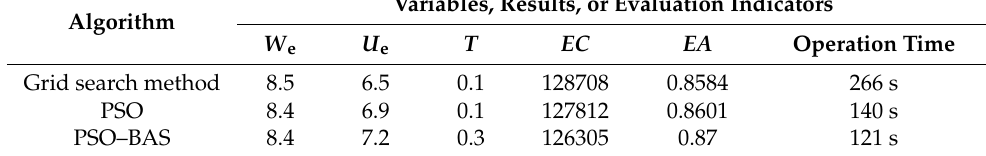
Table 5. Algorithm